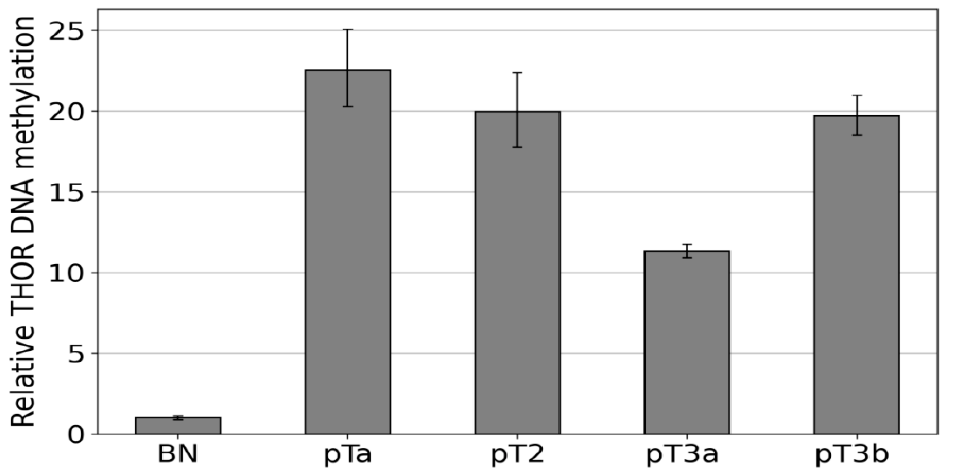
Figure 5. Methylation-specific amplification of the THOR region in urothelial carcinoma THOR methylation states were determined via IDLN-MSPCR in the following samples, pTa, pT2, pT3a, and pT3b. These were compared to a healthy control (BN).